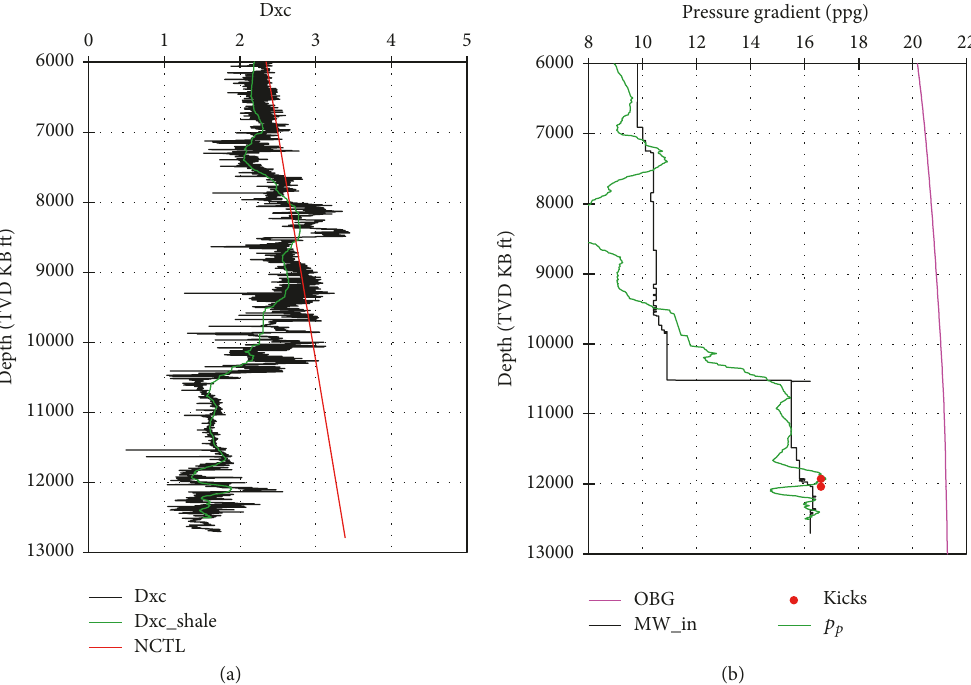
Figure 3: Pore pressure obtained from the corrected 𝑑 -exponent method with depth-dependent compaction trend line in a shale gas well. (a) plots the corrected 𝑑 -exponent in shale and the normal corrected 𝑑 -exponent calculated from (9) with 𝐷 0 = 1.5 and 𝑑 = 0.00015 . (b) shows the overburden gradient, mud weight, kicks, and pore pressure gradient calculated from the corrected 𝑑 -exponent (see